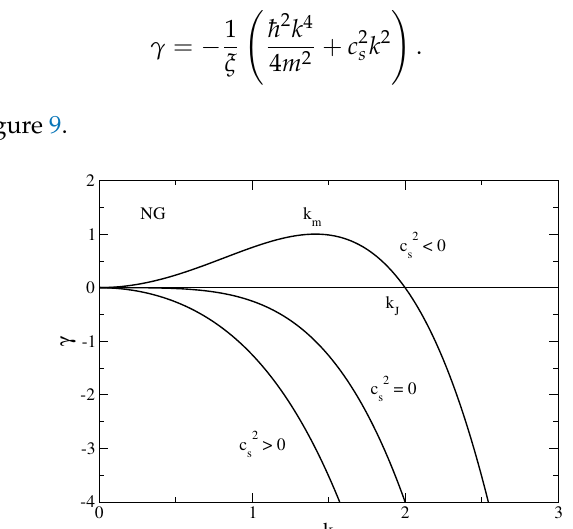
Figure 9. Exponential rate γ for overdamped BECs in the nongravitational limit ( G = 0). We have normalized the wavenumber by ( m 2 | c 2 s | /¯ h 2 ) 1/2 and the rate by m 2 c 4 s /¯ h 2 ξ . This is equivalent to taking m = | c 2 s | = ¯ h = ξ = 1 in the dimensional